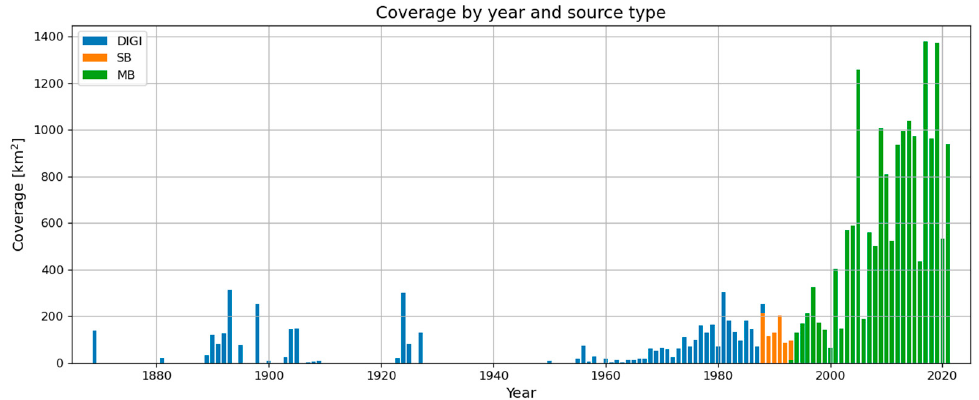
Figure 7. Coverage in km 2 by year and source type. The DDM shows the transition to modern SBES surveys (in orange) in 1988 and the transition to MBES surveys (in green) in 1993.